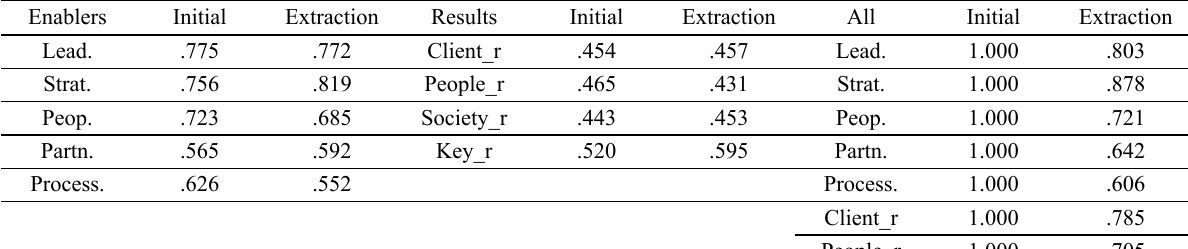
Table 4. The communalities of the three constructs